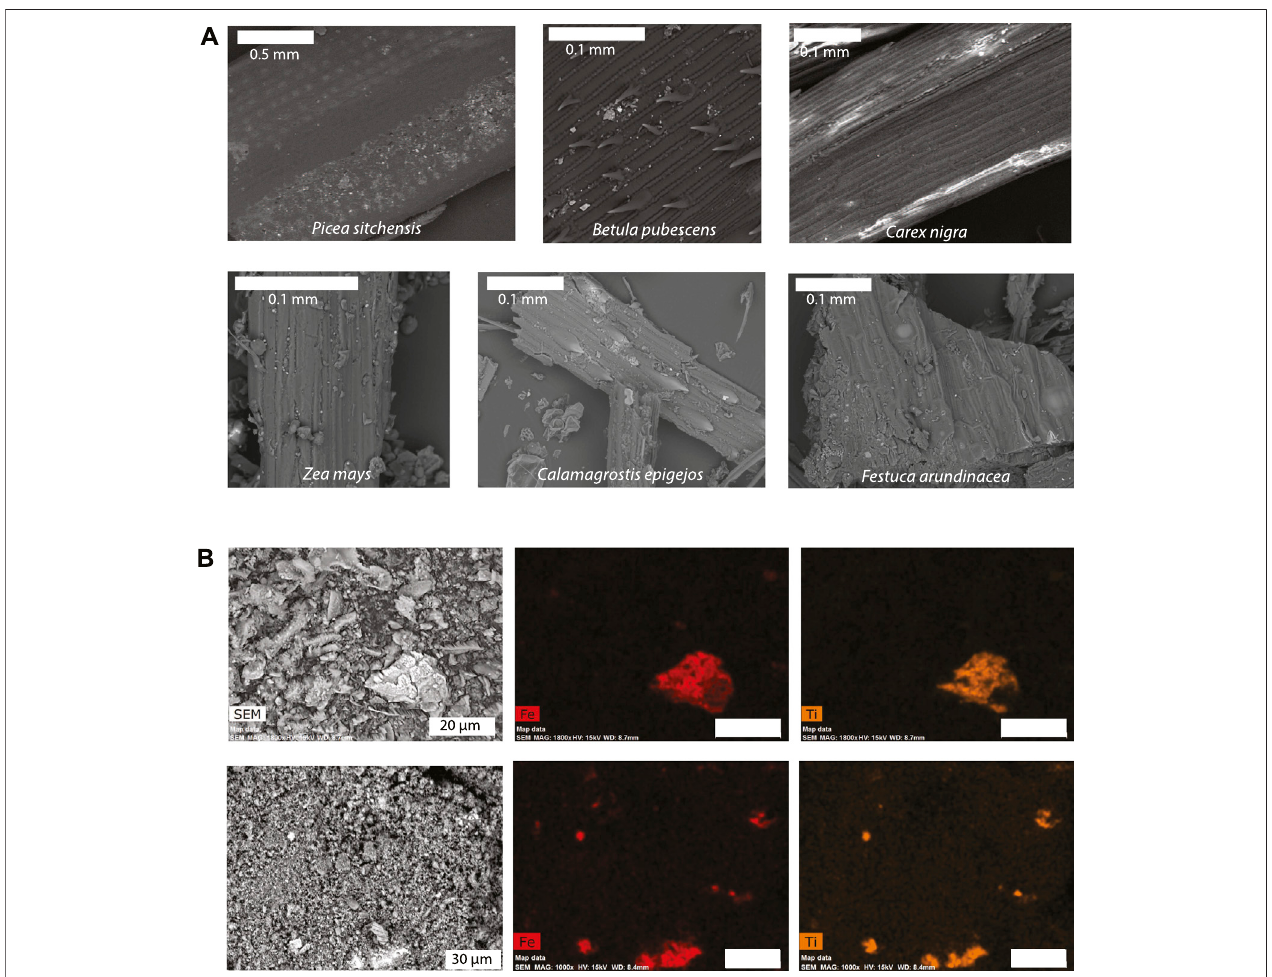
FIGURE 10 | SEM and EDS maps of plant and ash samples. (A) Backscattered electron images of Icelandic (top row) and German (bottom row) plant sample surfaces before burning. Small bright features are particulate matter. (B) EDS maps of Fe-bearing particles in Icelandic plant ash showing associations with Ti.